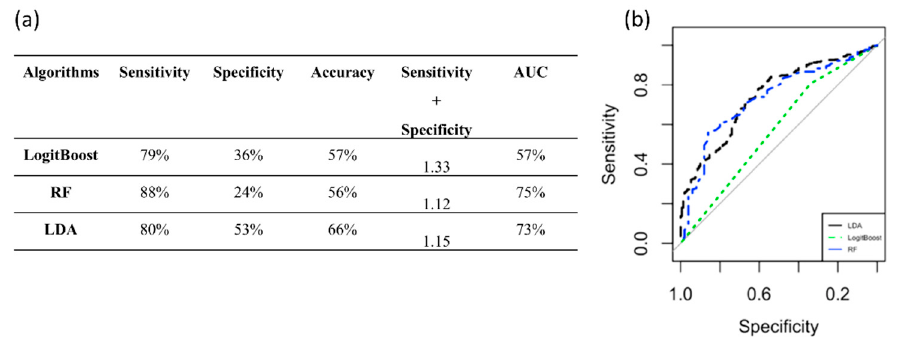
Figure 9. Performance measures to classify the tumor subtypes. ( a ) Algorithm performance via PC3 to classify the tumor subtypes. ( b ) ROC curves of the three classifiers. AUC: area under the curve; RF: random forest; LDA: linear discriminant